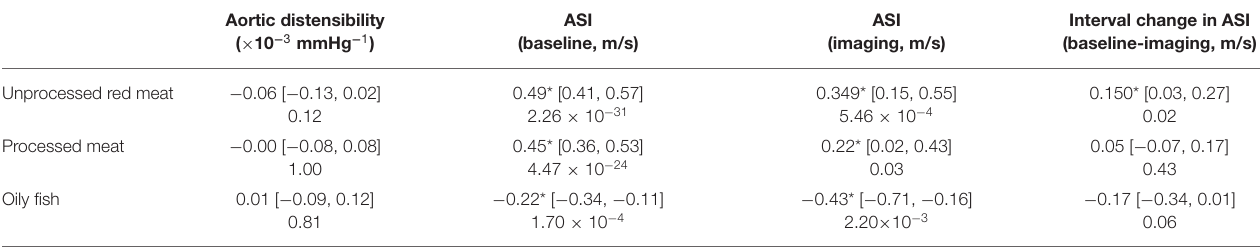
TABLE 4 | Multivariate linear regression models showing change in arterial compliance measures per 100g increase in daily meat/fish